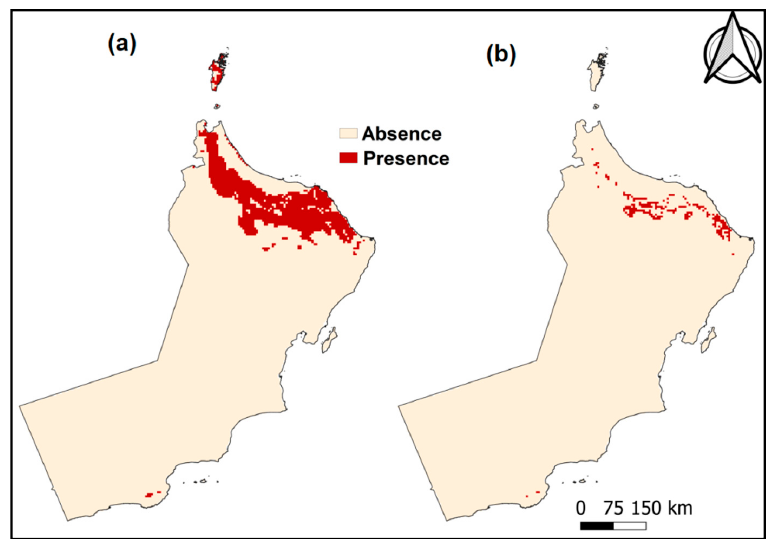
Figure 5. Presence and absence in the habitat for 16SrII-D using the maximum training sensitivity plus specificity threshold for ( a ) 2061-2080, ( b ) 2021-2040.